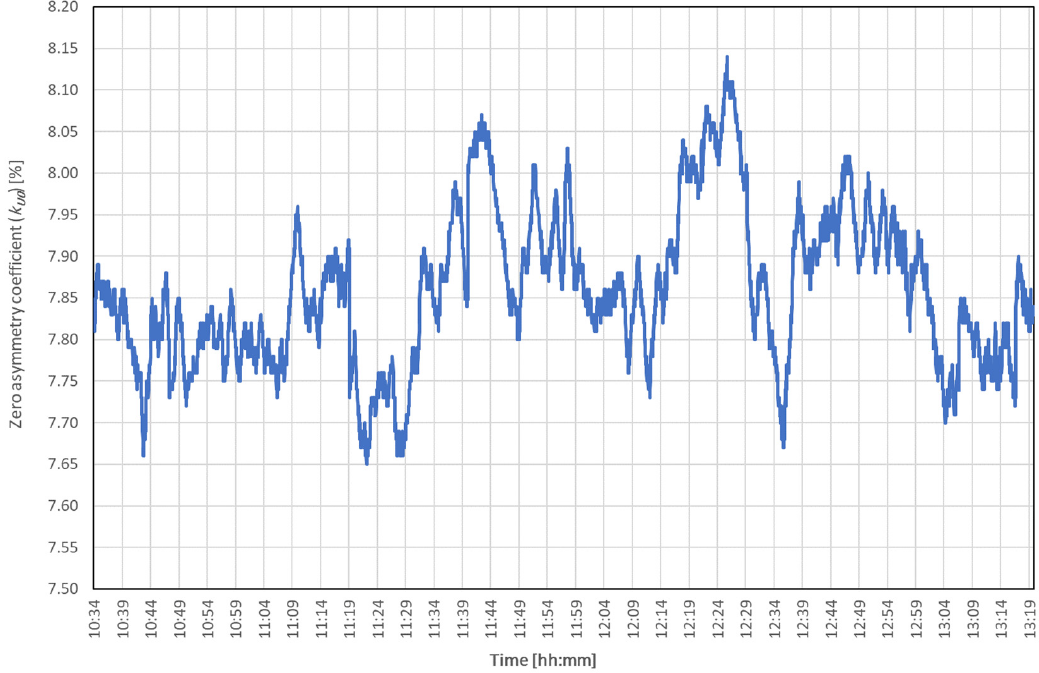
Figure 7. Time course of the value of the zero asymmetry coefficient ( k U0 ) at the wind power plant connection point.